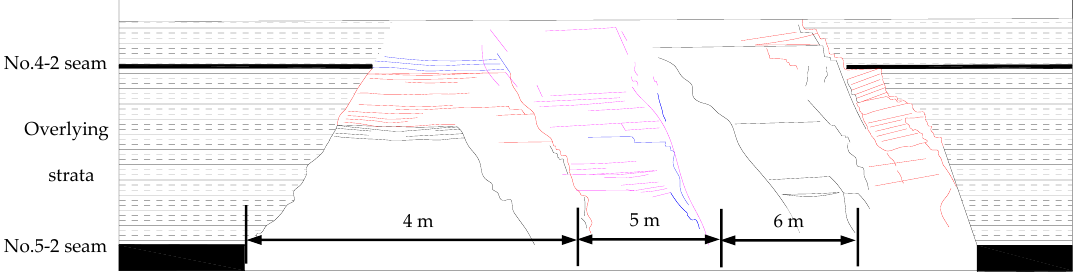
Figure 8. Sketch drawing of the dynamic periodic crack evolution under different mining heights.